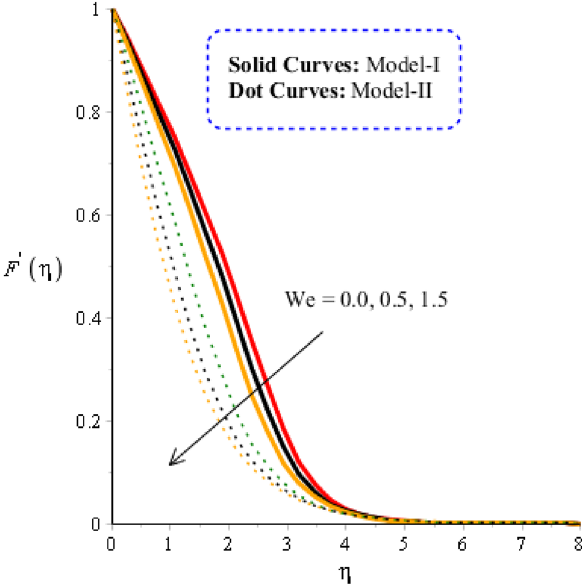
Figure 3. Graphical impact of We on velocity distribution when α = 0.5, m = 0.3, Re = 4.0, M = 3.0, Pr = 206, H